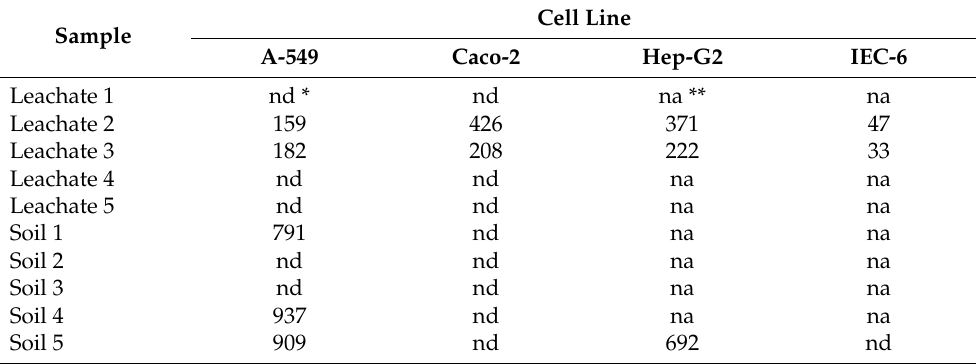
Figure 10. Cytotoxicity of soil extracts collected from the landfill in the PrestoBlue assay after 72 h * not detected; ** not exposure of A-549 lung and Caco-2 intestinal epithelial cells. Each data point represents the mean of the fluorescence values from the cells of the four replicates. Results are presented as mean ± SD.